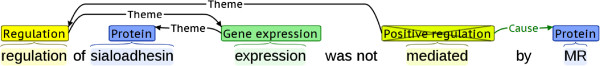
Example event annotations. Entities and event triggers shown with types above their corresponding text and event participants as arcs marked with roles. Each type shown in different colours. Negation visualised as “crossed-out” event.